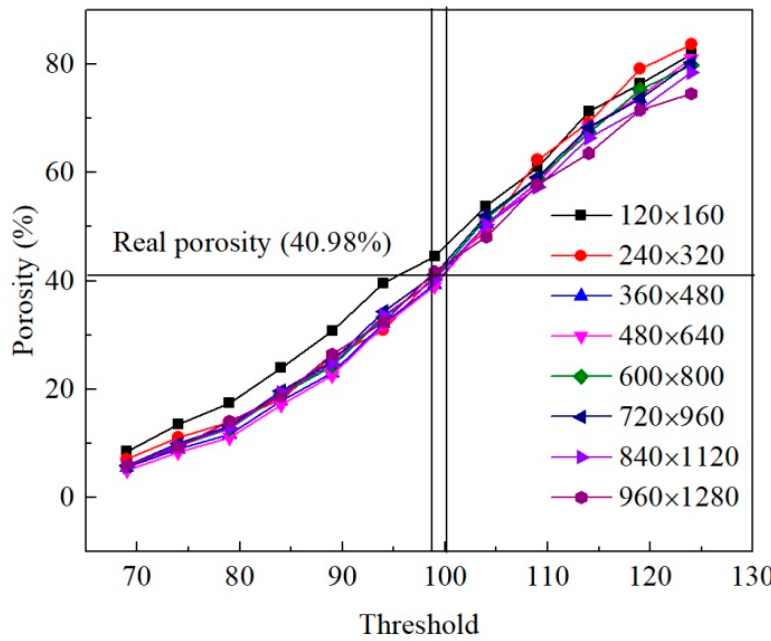
Figure 3. Relationship between porosity and threshold in different selection areas.